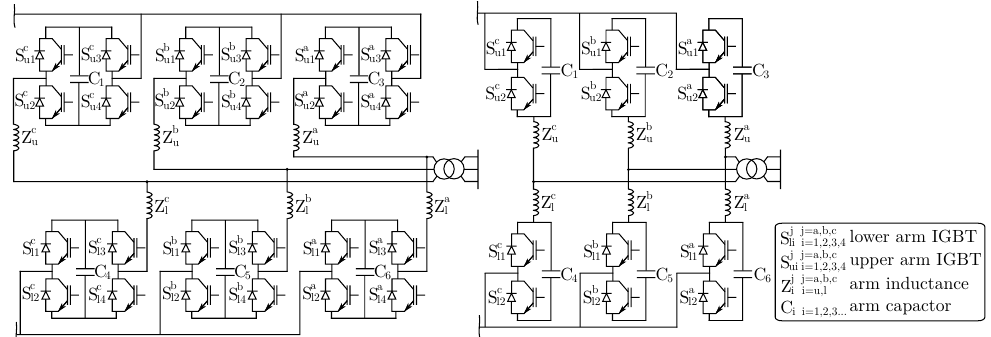
Figure 3. Scheme of the proposed modular multilevel converter with one cell per arm (half-bridge and full-bridge